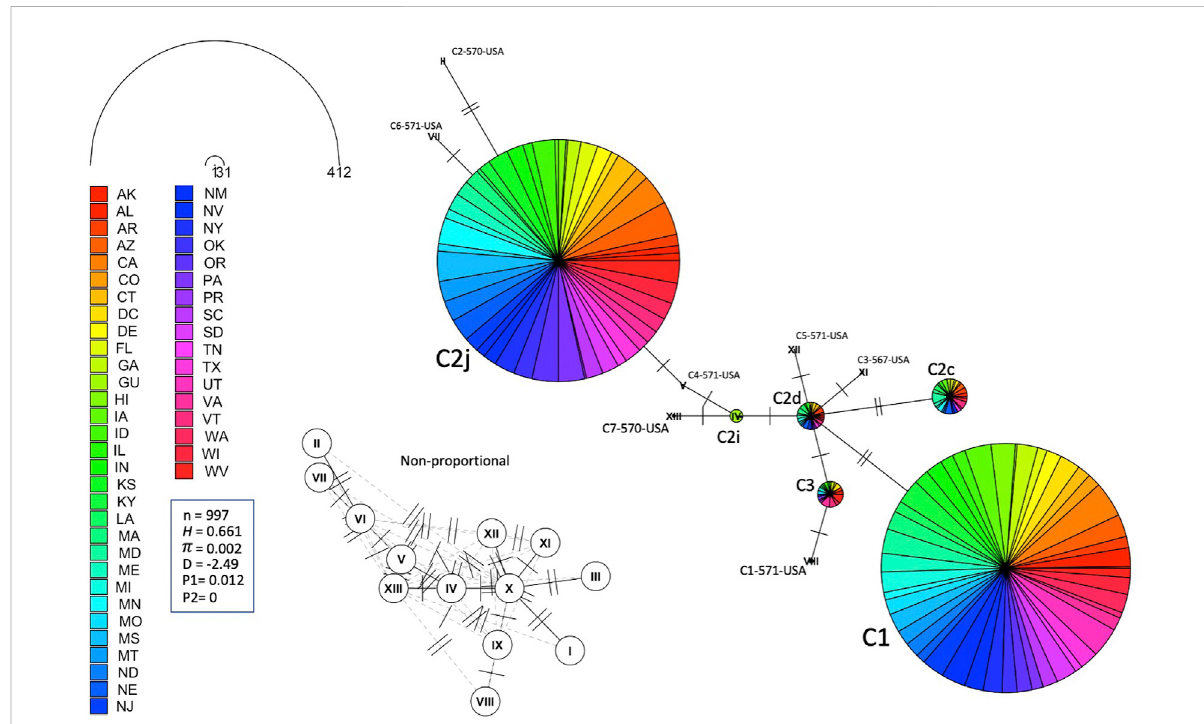
FIGURE 6 Haplotype network of the mtDNA COI-COII region for samples of Lineage C represented by states. Number of samples (n), haplotype diversity ( H ),nucleotidediversity( π ),Tajima ’ sstatistic(D),Tajima ’ s p -valuesundernormal(P 1 )andbeta(P 2 )distributions.Circlesizeisrelativetothenumberof haplotype copies in the dataset. Perpendicular lines on branches represent SNP events. Non-proportional sub fi gure shows haplotype secondary network (dotted line) without haplotype copy representation. C2j and C1 are the two major haplotypes (76.64%) identi fi ed in the USA populations.